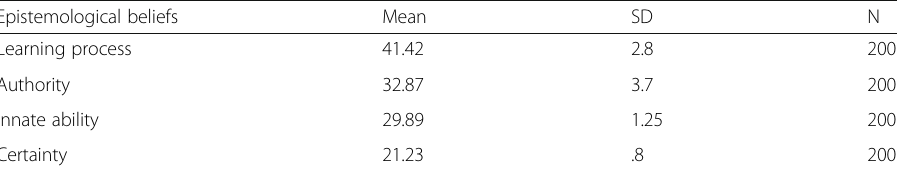
Table 2 Descriptive statistics of EBS